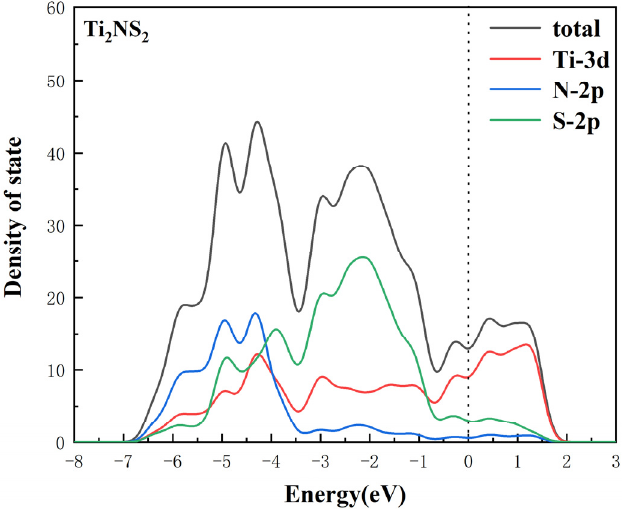
Nanomaterials 2021 , 11 , x FOR PEER REVIEW